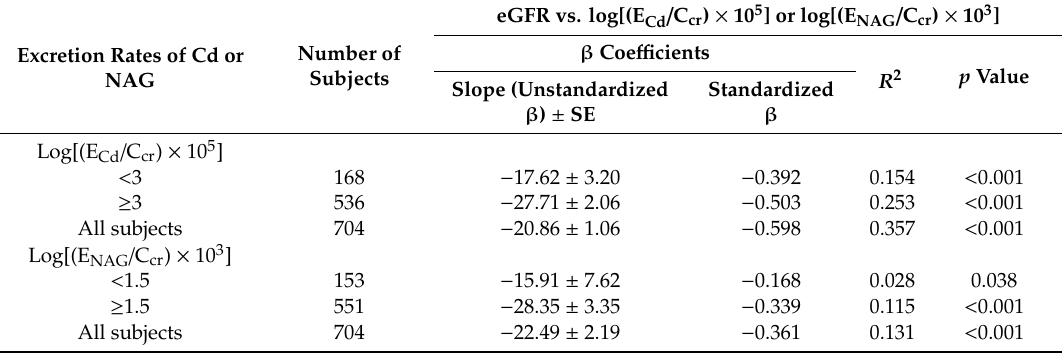
Figure 2. E NAG / C cr as a predictor of eGFR. Scatterplots compare eGFR to log[(E NAG / C cr ) × 10 3 ] in subjects grouped by locality ( A – C ) and in all subjects ( D ). Quadratic and linear coefficients of determination ( R 2 ) are provided together with corresponding equations, standardized β coefficients, and p -values. Table 2. Slope analysis for comparing rates of eGFR reduction.